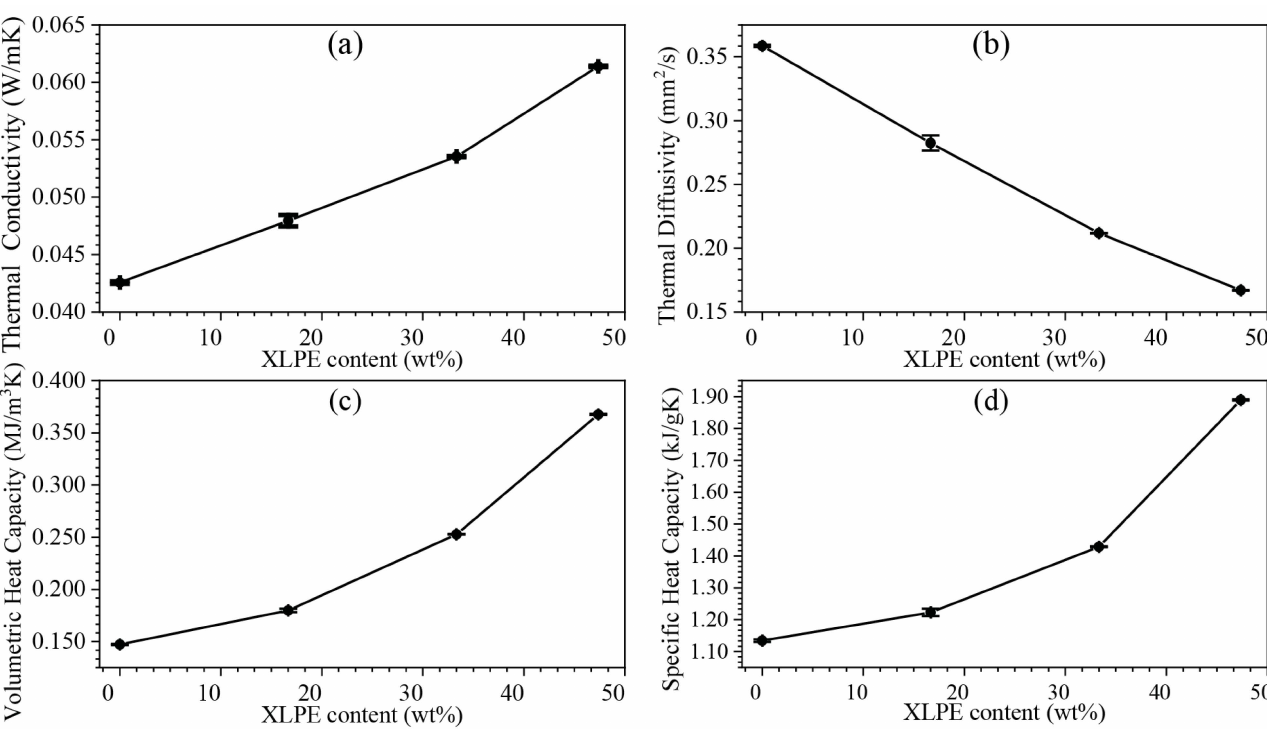
Figure 8. Result of thermal properties of RPUF with varying XLPE percentages: ( a ) thermal conduc- tivity, ( b ) thermal diffusivity, ( c ) volumetric heat capacity, and ( d ) specific heat